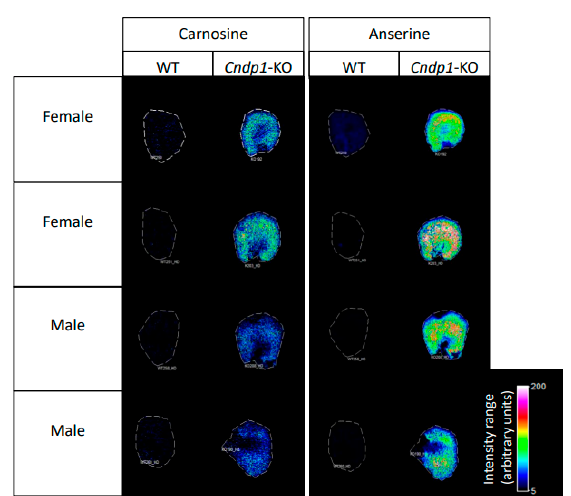
Figure 2. MALDI-MS Imaging of renal carnosine and anserine concentrations. MALDI-MSI confirmed increased carnosine and anserine levels in two female and 2 male, 55-week-old Cndp1 -KO mice, as compared to respective WT mice. Both dipeptides are primarily localized in the kidney cortex.